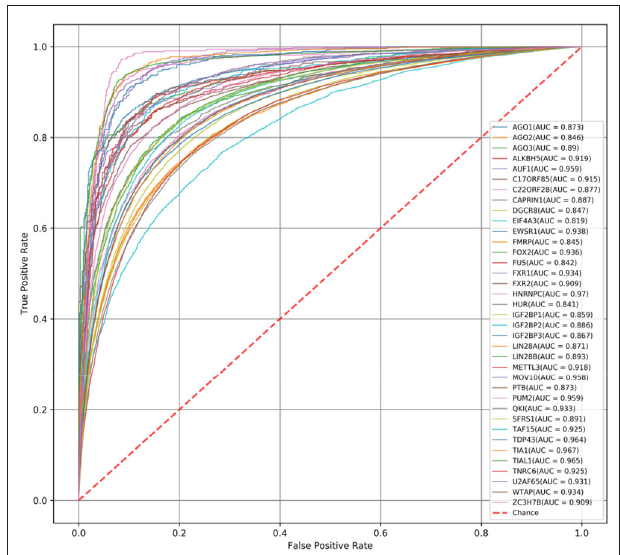
FIGURE 3 | The ROC curves obtained by DeCban for 37 circRNA data